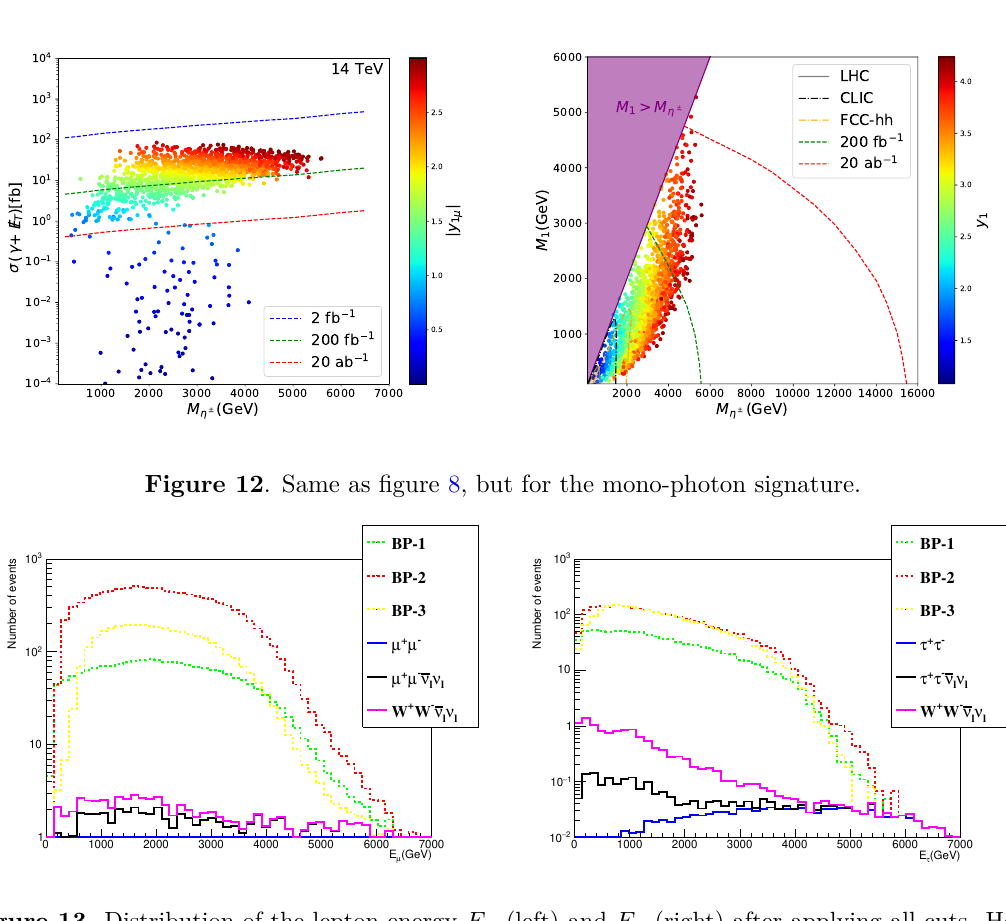
Figure 13 . Distribution of the lepton energy E µ (left) and E τ (right) after applying all cuts. Here, we assume an integrated luminosity of 200 fb − 1